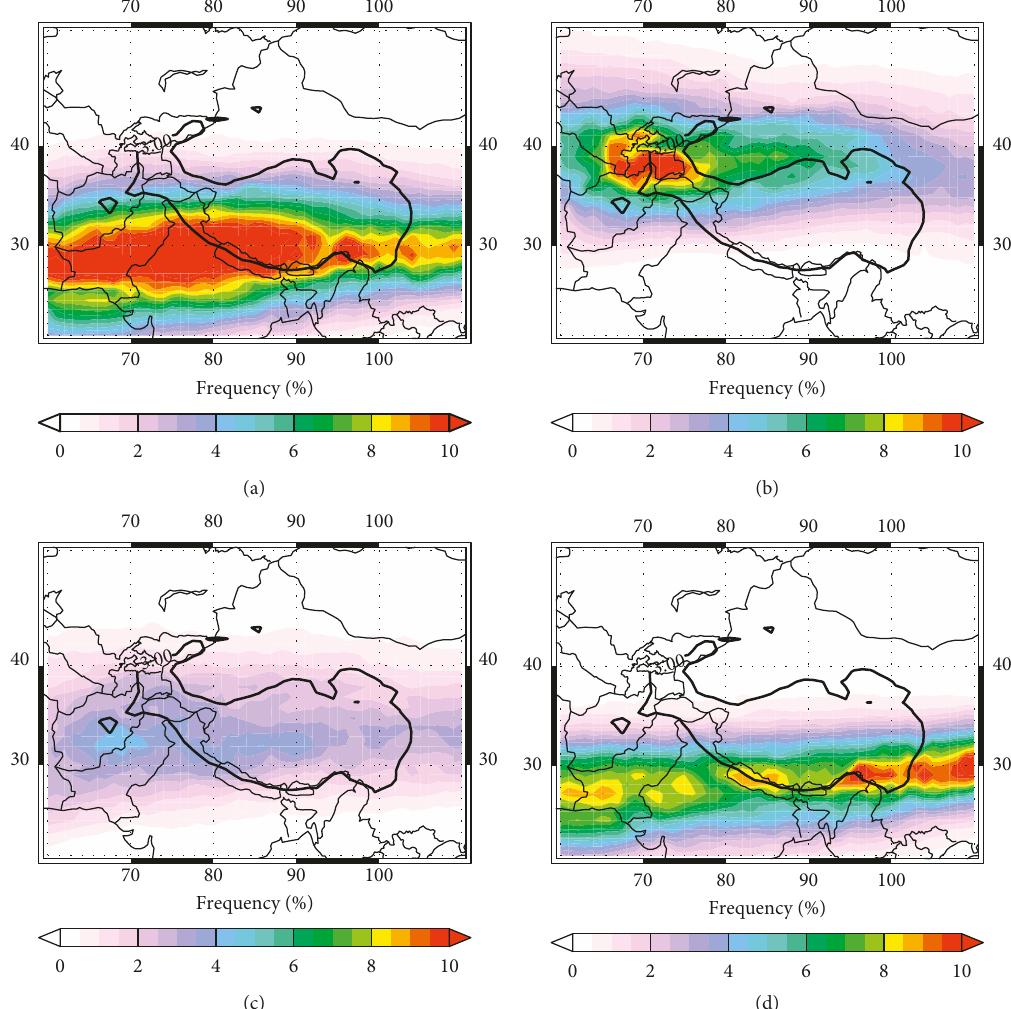
Figure 3: Seasonal averages of shallow tropopause fold frequencies (%) for spring (March, April, and May (MAM)) (a), summer (June, July, and August (JJA)) (b), autumn (September, October, and November (SON)) (c), and winter (December, January, and February (DJF)) (d) during 1979–2018. The location of the Tibetan Plateau (3km elevation) is also shown in the maps (black